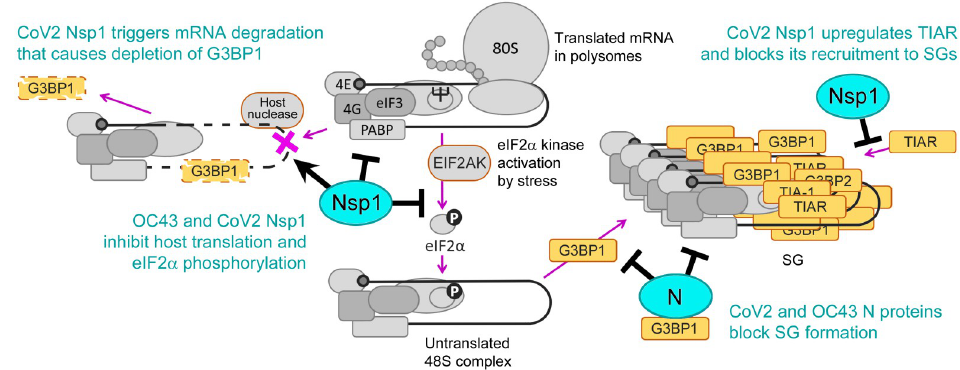
Fig 9. Working model for the inhibition of SG formation by Nsp1 and N proteins. Diagram illustrating concerted action of N and Nsp1 proteins in disrupting G3BP1 activity and inhibiting SG formation. Poly(A) binding protein (PABP) and the eukaryotic translation initiation factors eIF3, eIF4E (4E), and eIF4G (4G) that form preinitiation complex and recruit ribosomal subunits are shown schematically. EIF2AK = eIF2 α kinase.